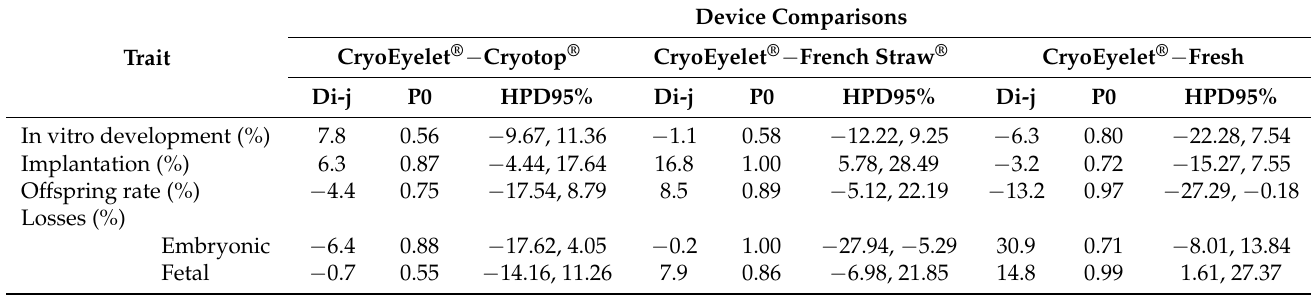
Table 2. Embryo viability rates differences using CryoEyelet ® , Cryotop ® , and French Straw ® devices and a fresh control group. Data computed as CryoEyelet ® − Cryotop ® , CryoEyelet ® − Straw ® and CryoEyelet ® − Fresh.